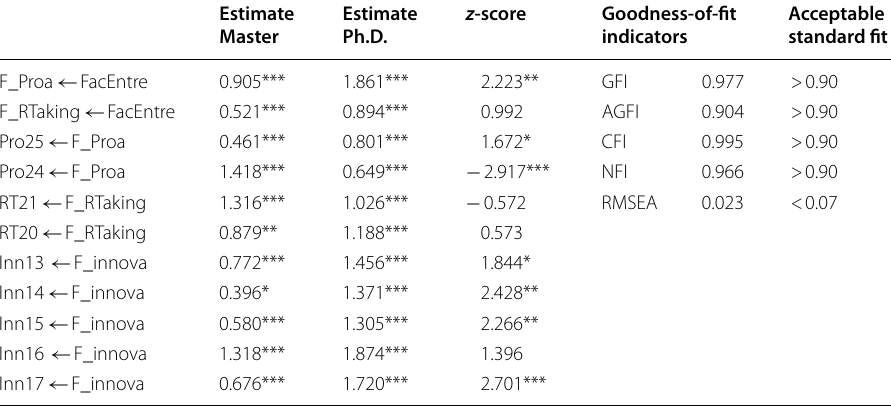
Table 5 SEM results for FEO construct subject to